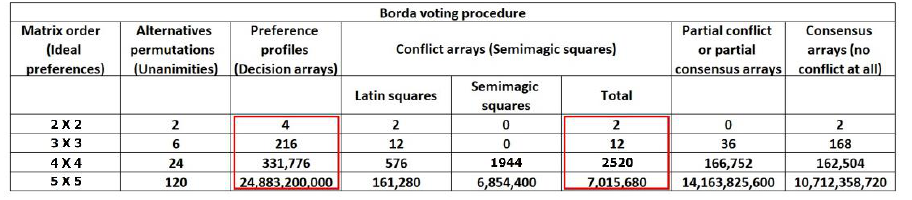
Figure 8. Summary of Borda voting procedure matrices size with n=2, 3, 4, 5.